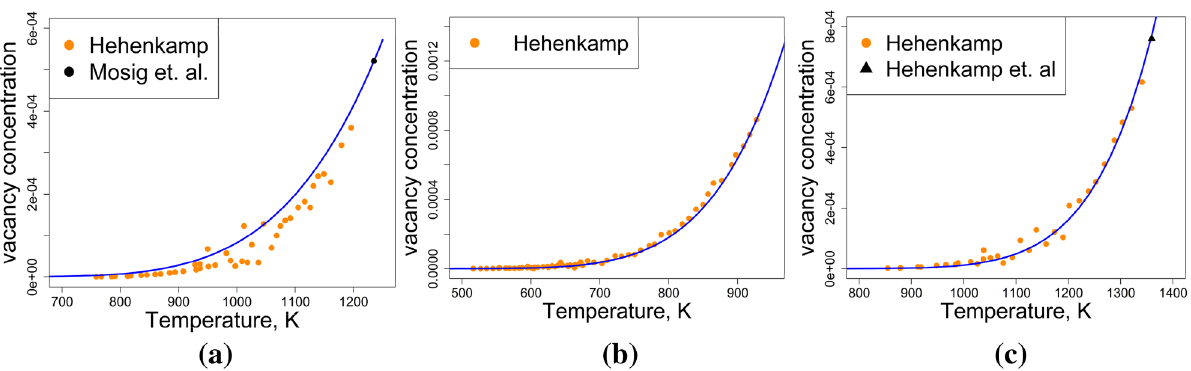
Figure 7. Vacancy concentration results from the proposed model for ( a ) FCC-Ag ( b ) FCC-Al (c) FCC-Cu compared with experimental data from Hehenkamp 36 , Hehenkamp et al. 52 , and Mosig et al. 53